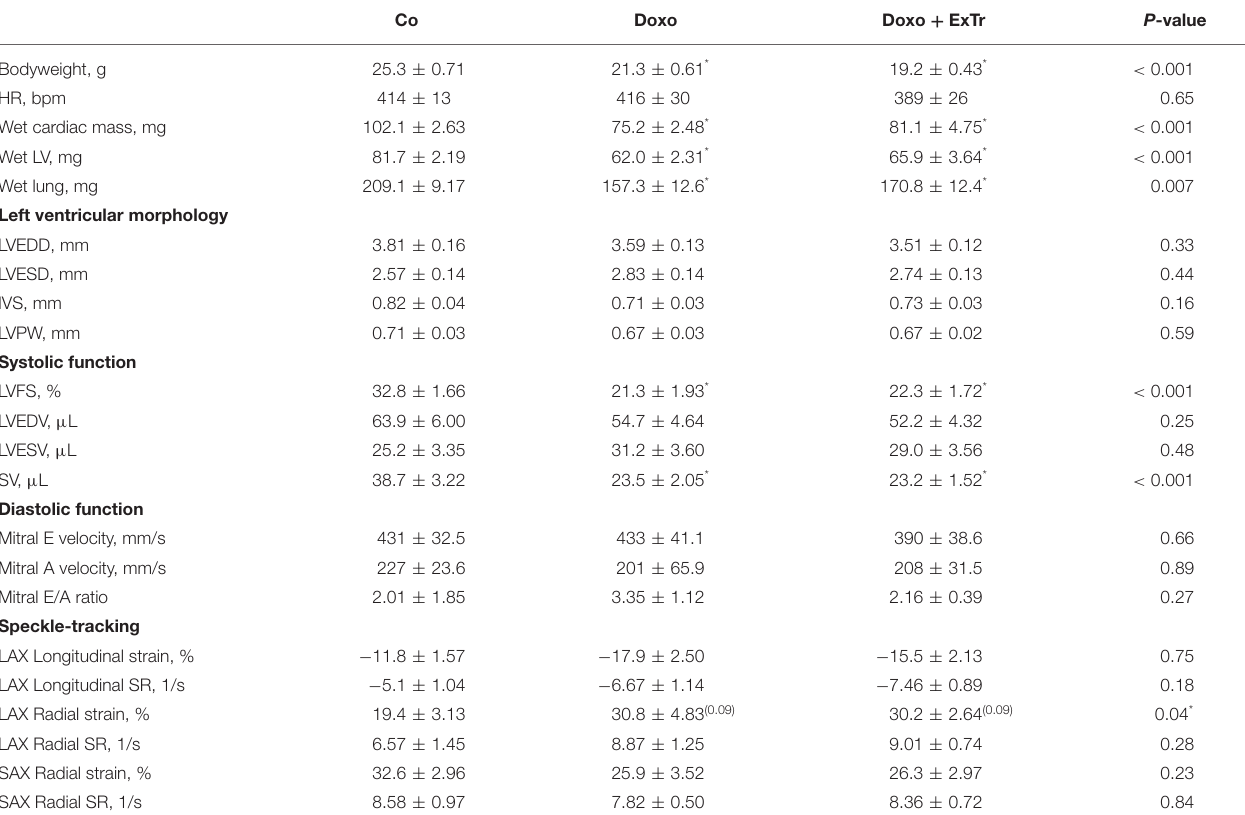
TABLE 2 | Physical characteristics, ventricular morphology, and function after 5 weeks of saline or doxorubicin treatment.